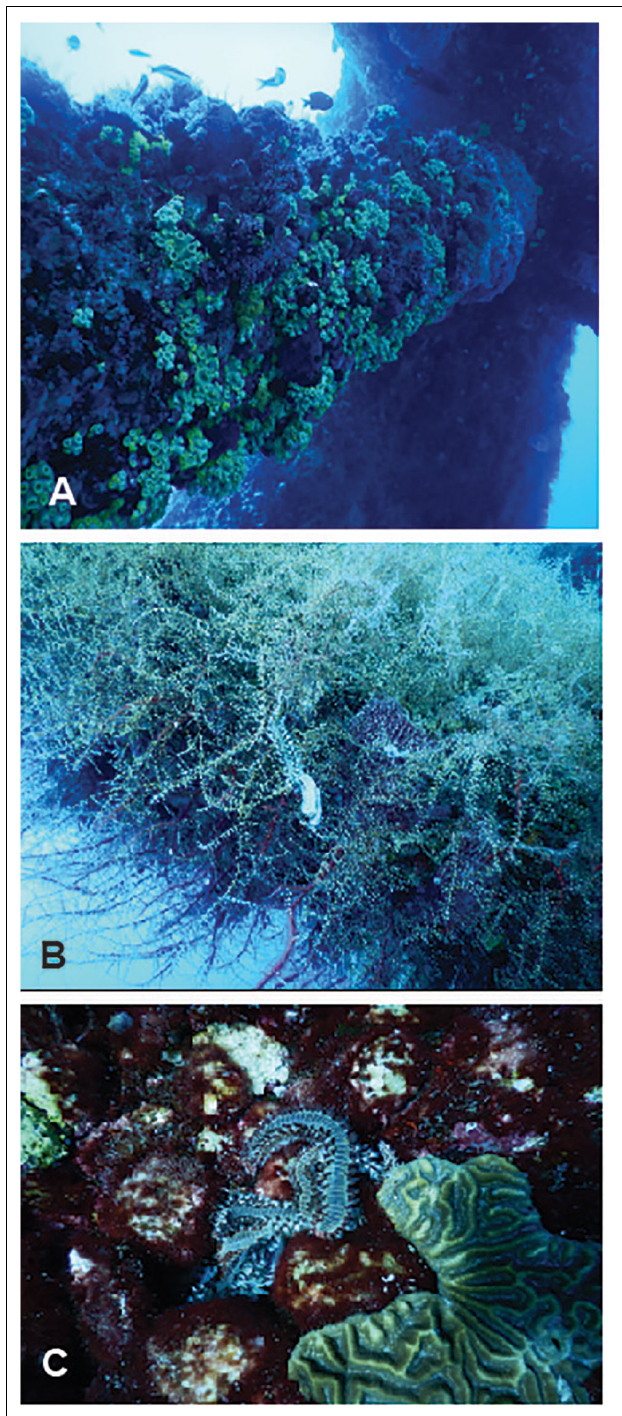
FIGURE 2 | Examples of the fouling community and associated motile fauna on High Island 389A (HI-389A). (A) Numerous colonies of Tubastrea coccinea shown on the underside of a horizontal beam of at 37 m. (B) The hydroid, Thyroscyphus sp., with a bearded fireworm, Hermodice carunculata , on top on a diagonal structure support beam on HI389-A at 20 m. (C) Five bearded fireworms, H. carunculata , in close proximity to a scleractinian coral ( Pseudodiploria strigosa ) on a horizontal beam of HI389-A at 9